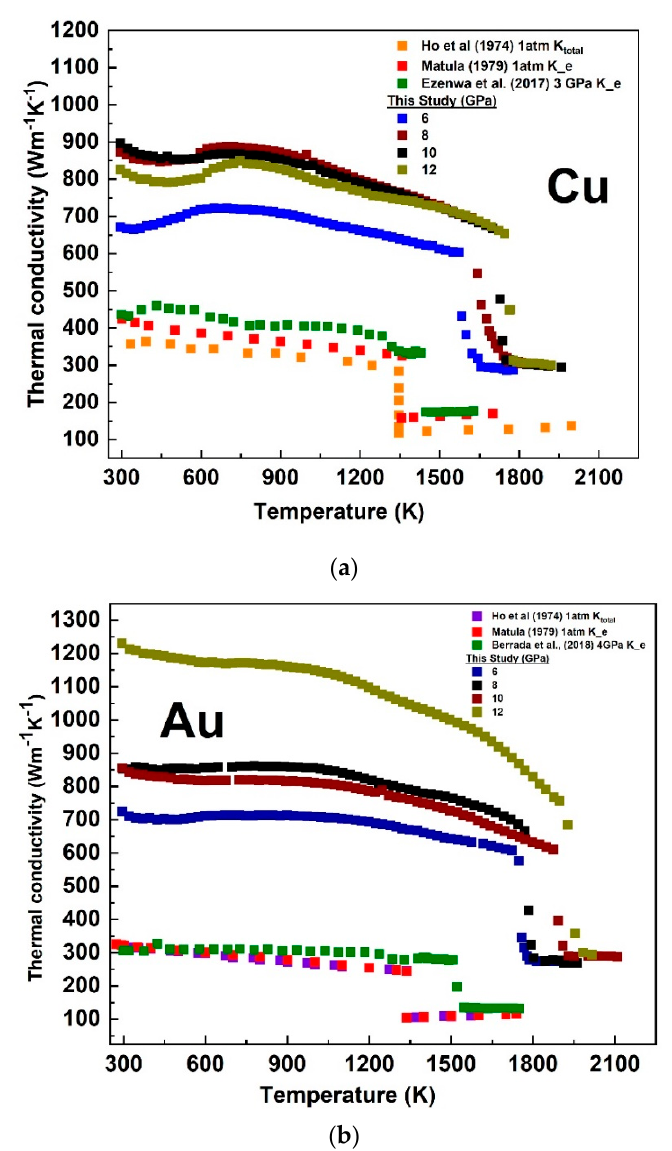
Figure 9. The temperature − dependent electronic component of the thermal conductivity of Cu ( a ) and Au ( b ) at pressures ranging from 6 to 5 GPa calculated from the electrical resistivity data, using the Wiedemann–Franz law with the Sommerfeld value of the Lorenz number. The data are compared to those calculated from the electrical resistivity reported at 1 atm and those measured at relatively lower pressure compared with the measured total thermal conductivity.